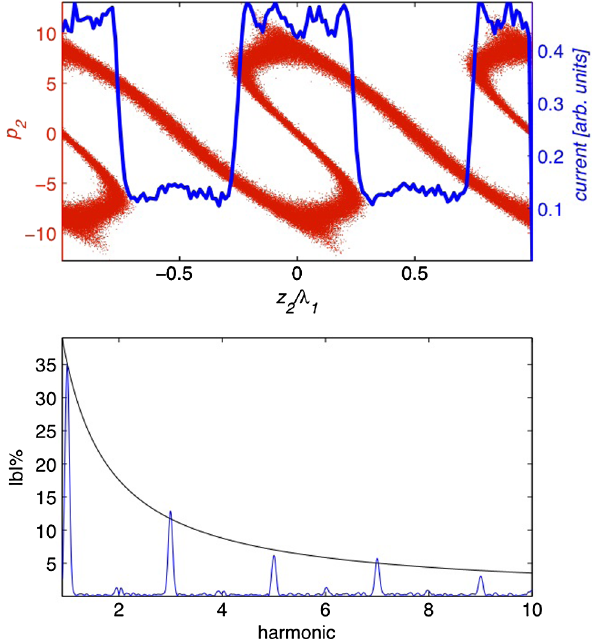
FIG. 8. Two-modulator generation of odd-harmonic bunching with amplitudes b ½ð 2 h (cid:1) 1 Þ k 1 (cid:5) ¼ b ð k 1 Þ = ð 2 h (cid:1) 1 Þ for the emis- sion of square-wave fields. Top: Modified phase space and current distribution with A 1 ¼ 10 , A 2 ¼ 1 : 388 , B 1 ¼ 0 : 295 , B 2 ¼ (cid:1) 0 : 551 , (cid:3) 2 ¼ (cid:3) 3 ¼ 0 . Bottom: Bunching factors com- pared with 1 = ð 2 h (cid:1) 1 Þ dependence of square-wave